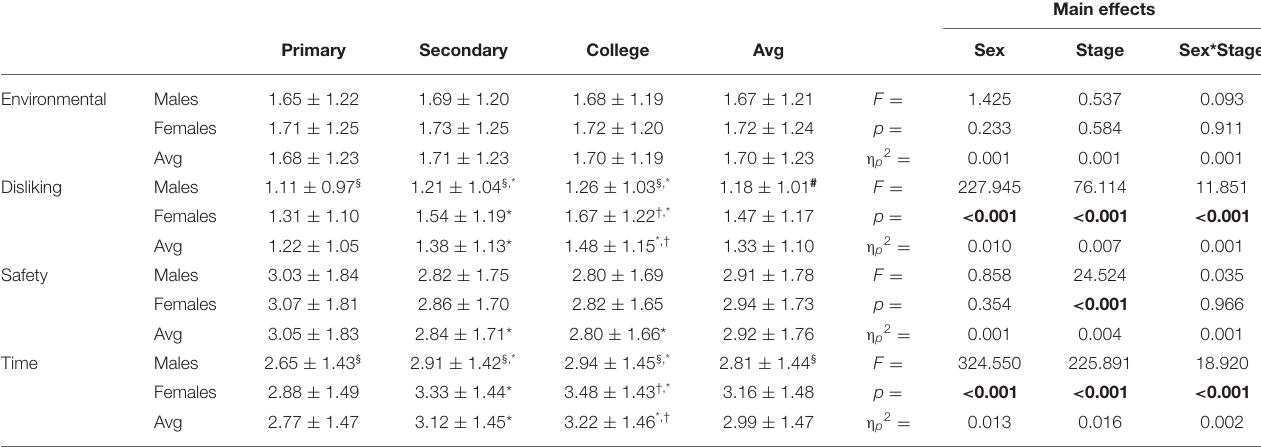
TABLE 2 | Barriers to PA according to sex and educational